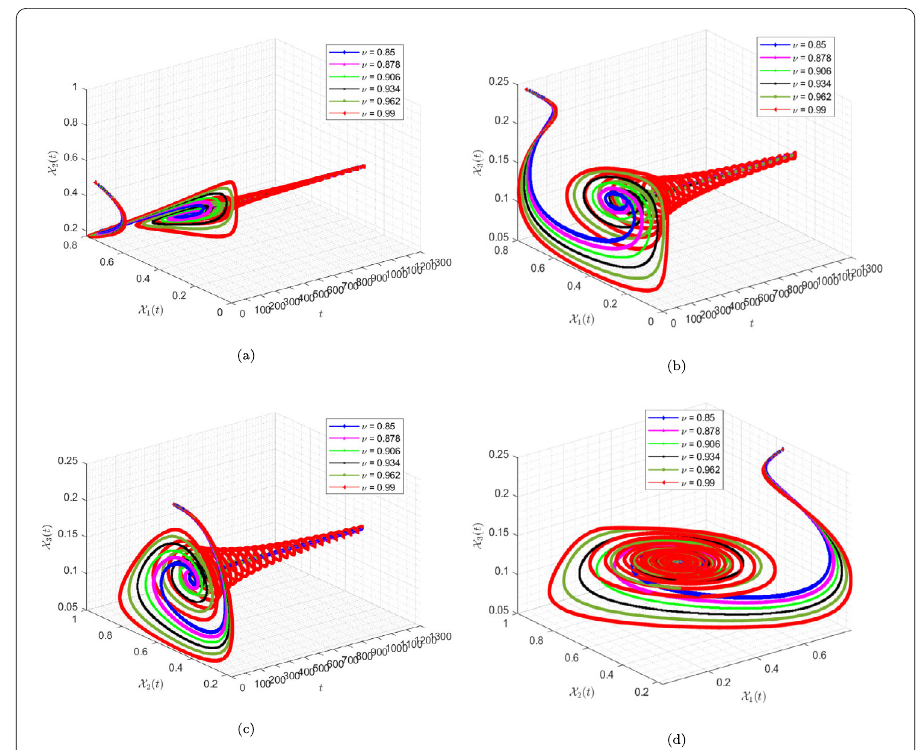
Figure 8 Dynamics for system (19) for different parameters in